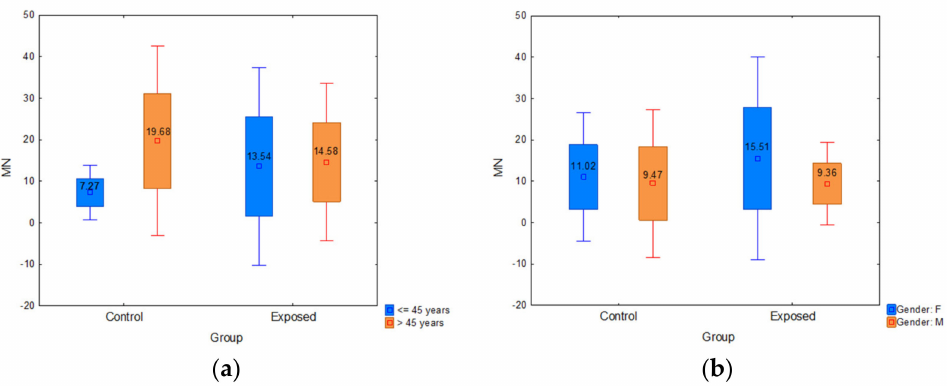
Figure 5. ( a ) Influence of participants’ age on micronucleus frequency; ( b ) influence of participants’ gender on micronucleus frequency. Control—unexposed volunteers; exposed—workers subjected to antineoplastic drugs or ionizing irradiation.